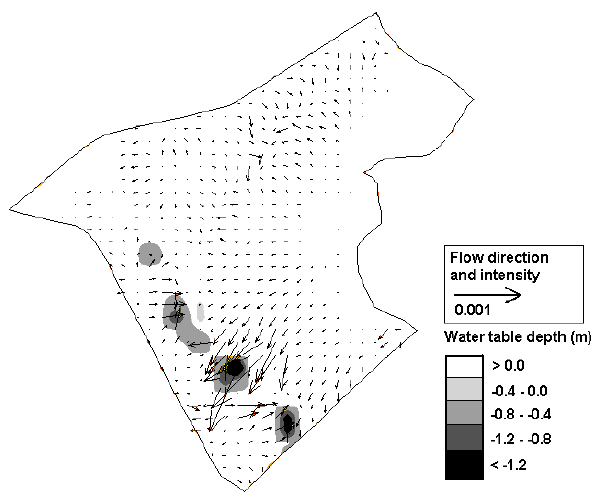
Fig. 8a. Spatial distribution of water table depth and flow direction after an intense storm. 1